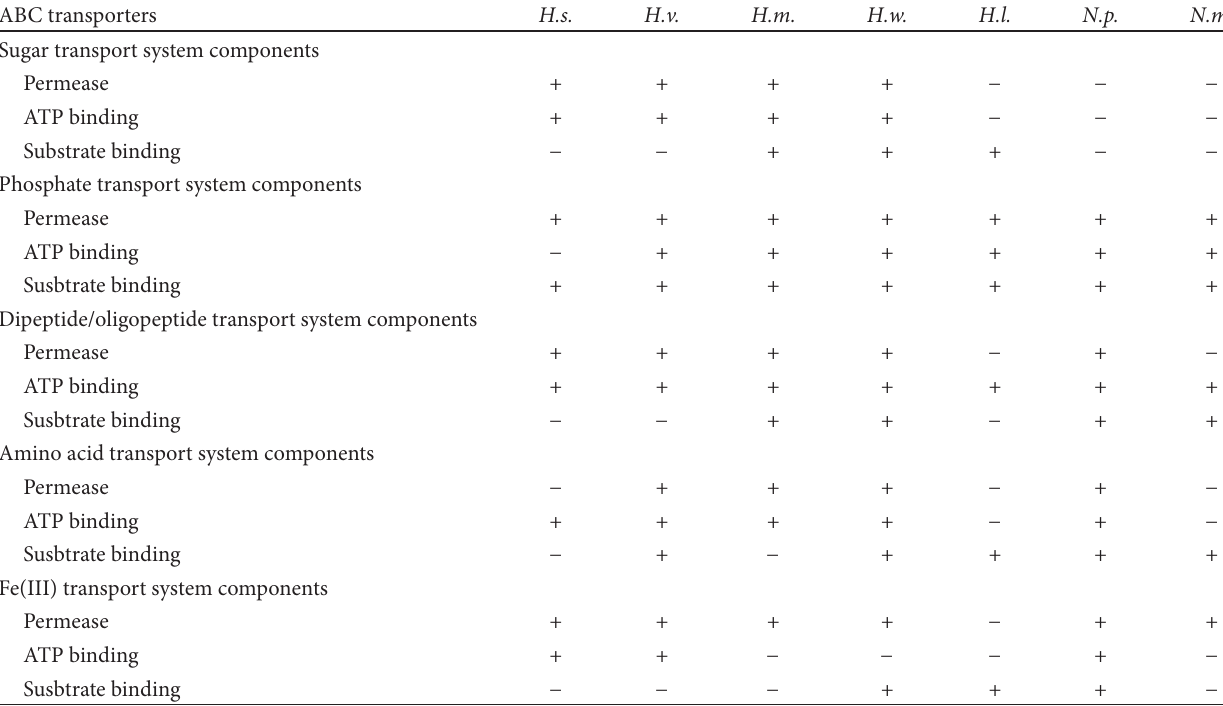
Table4:ABCtransporterswithvariousfunctionspresentinsomemodelhaloarchaea.ABCtransportershavethreecomponentsthattogether helpinuptakeofnutrientsorfortheeffluxofextracellularproteins,enzymes,andtoxicants.Permeaseisthetransmembranecomponentandis responsiblefortheuptakeofionsormacromolecules,whiletheATP-bindingcomponentisthewatersolubledomainthatbindsATP.Substrate binding at the substrate binding site brings about a conformational change in the ATP-binding component resulting in ATP hydrolysis. The presence or absence of the three components of ABC transporters for sugar, peptide, amino acids, phosphate, and iron transport is shown in the following table [135,